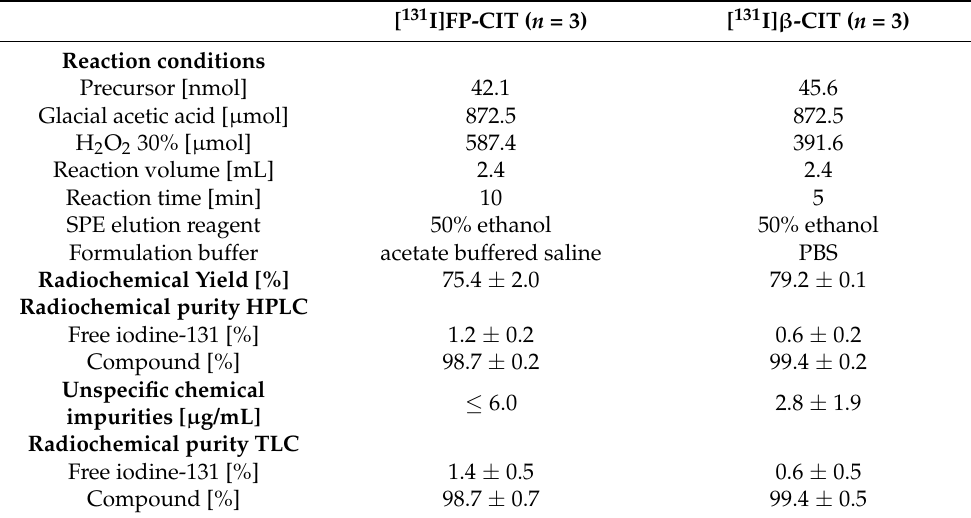
Table 1. Summary of the reaction conditions and results of the automated radiolabeling of [ 131 I] β -CIT and [ 131 I]FP-CIT.